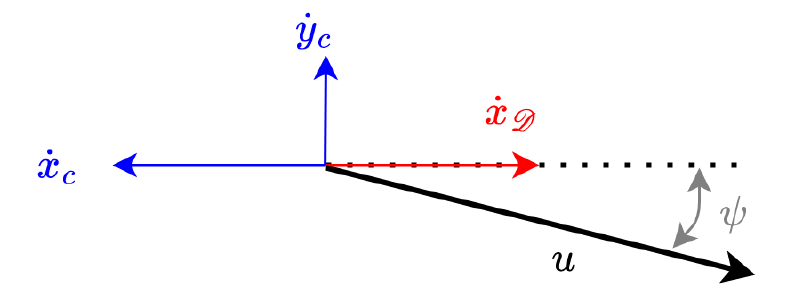
Figure 2. Geometrical representation of basic